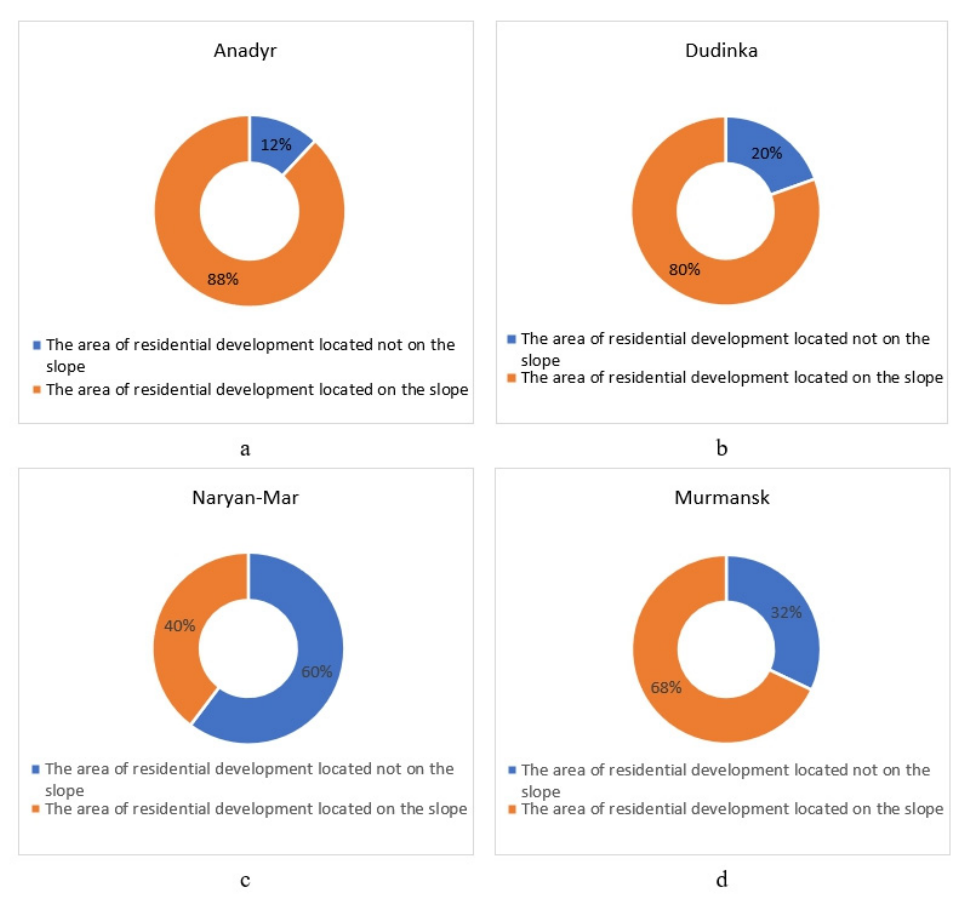
Figure 4. The ratio of residential areas, located on slopes, to residential areas located on flatlands: ( a ) Anadyr, ( b ) Dudinka, ( c ) Naryan-Mar, and ( d ) Murmansk.